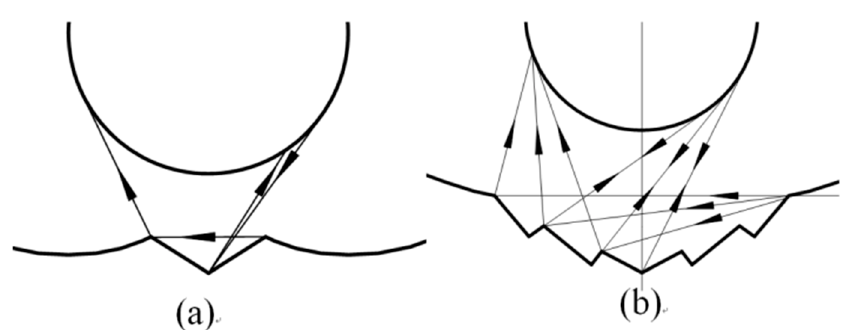
Figure 3. Schematic of the new V-shaped CPC: ( a ) Single V-shaped CPC; ( b ) multi V-shaped CPC [27].